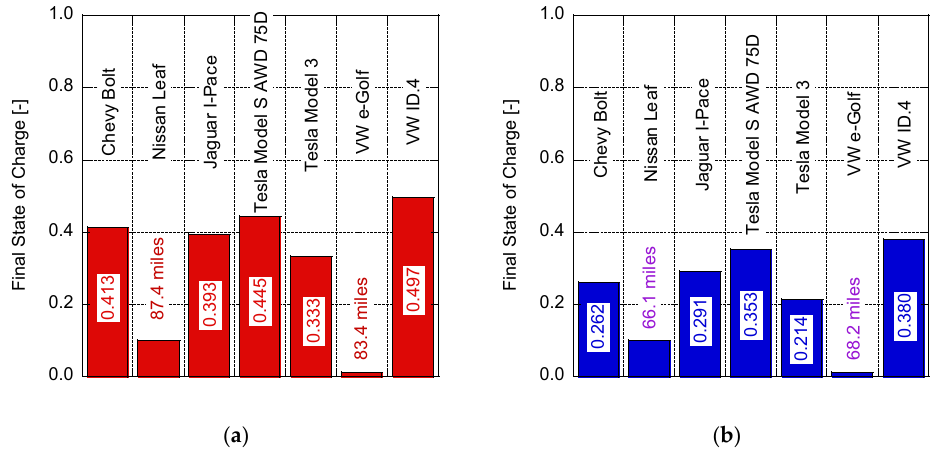
Figure 19. Final state of charge of each vehicle or the vehicle range when driving from ( a ) Wichita, KS, to Salina, KS, or ( b ) Salina, KS, to Wichita, KS, on I-135 North and South, respectively, during